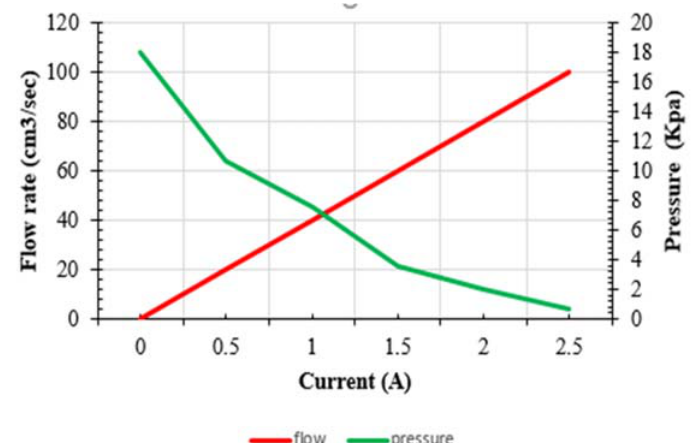
Fig. 11. Magnetic flux density(B) in FEMM software when I=0A.